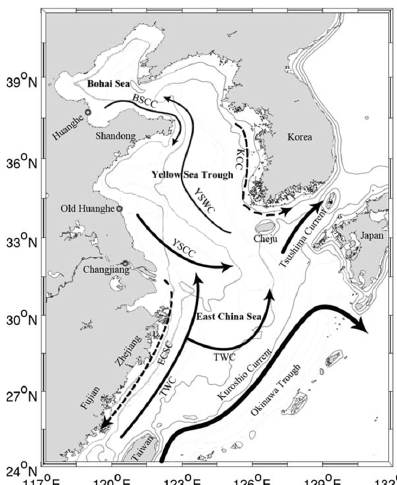
Figure 2. A schematic map of the most influential currents around East China Sea in summer and winter. Arrows with solid lines represent currents that flow in the same direction during both seasons; Arrows with dashed lines indicate the winter currents that flow in the opposite directions during the summer. Abbreviation of the currents: the Bohai Sea Coastal Current (BSCC), the Yellow Sea Warm Current (YSWC), the Yellow Sea Coastal Current (YSCC), the Taiwan Warm Current (TWC), the Korea Coastal Current (KCC) and the East China Sea Coastal Current (ECSCC). This figure is based on the research of Bian et al. Reprinted/adapted with permission from Ref. [36]. 2013.